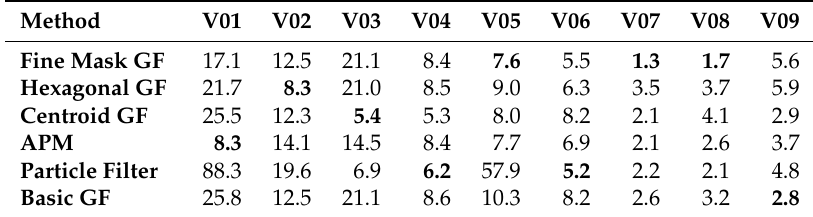
Table 5. Third quartiles of errors in meters for considered methods with the best overall result on each validation logfile.